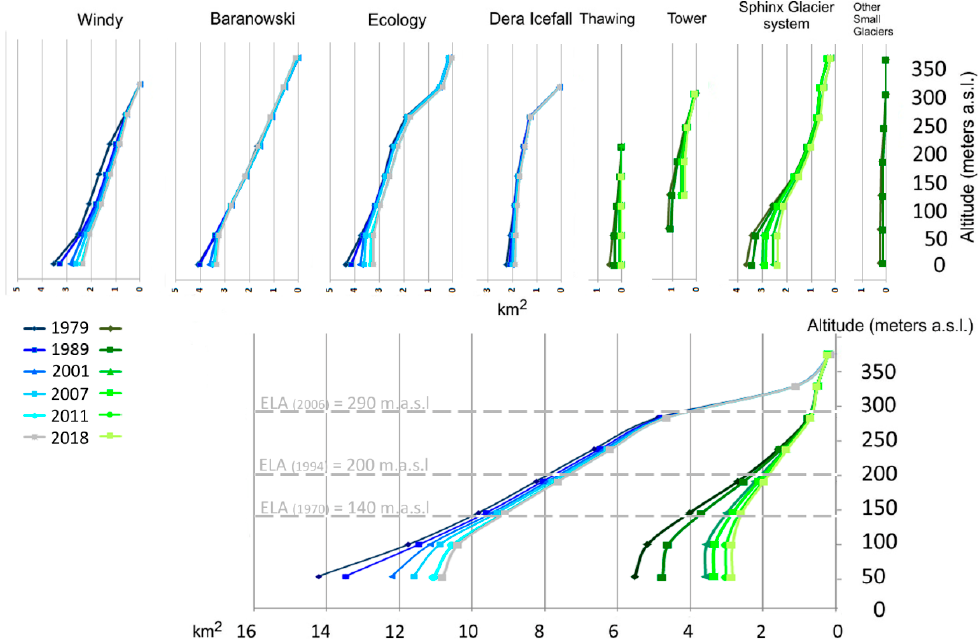
Figure 7. The changes in the altitude profiles of the studied glaciers. The land-terminating glaciers are in green and the tidewater glaciers are in blue. For simplicity, the zones Xa and Xb were grouped together as ‘Other Small Glaciers’ and the zones E-S, R, Sa, and Sb were grouped together as ‘Sphinx Glacier system’.